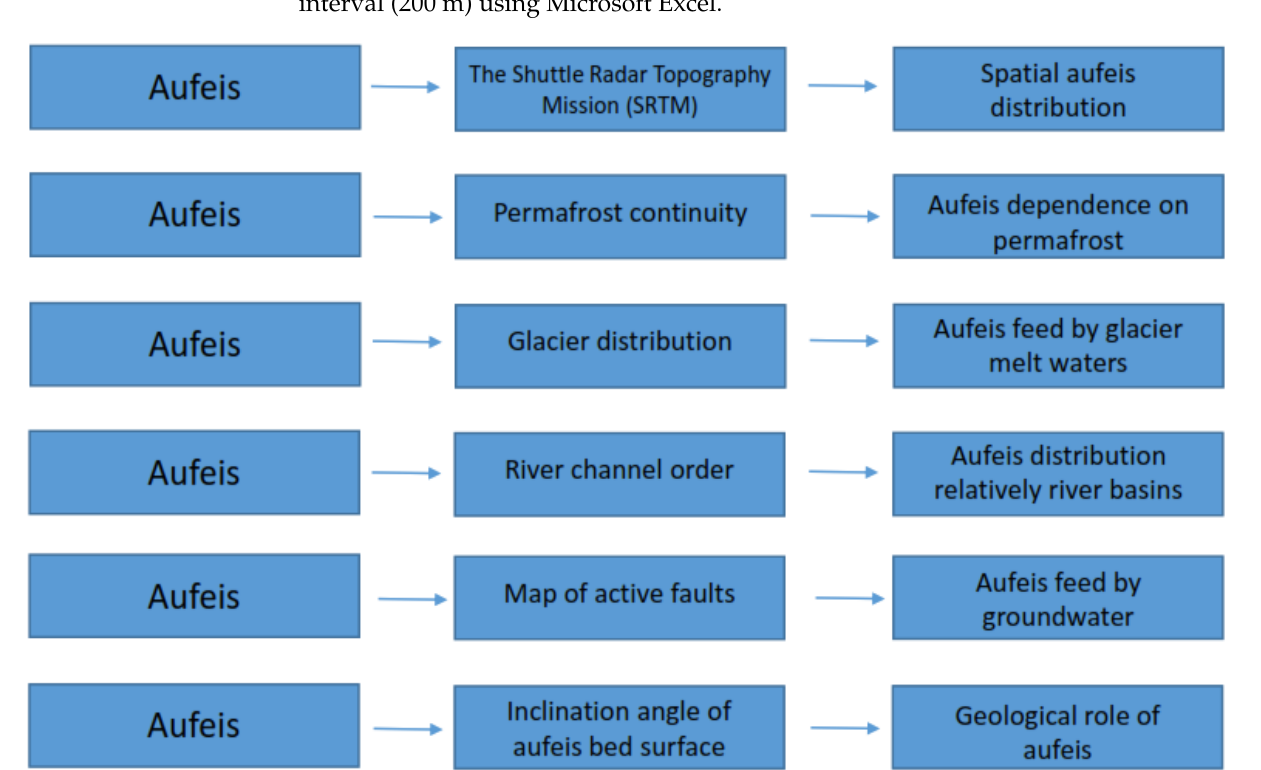
Figure 2. Fragments of Landsat 8 OLI imageries (IRGB) with Aufeis contours. Description: ( A ) — typical gigantic Aufeis; ( B ) — groups of sloping Aufeis; ( C , D ) — Aufeis fed by melt glacier water.